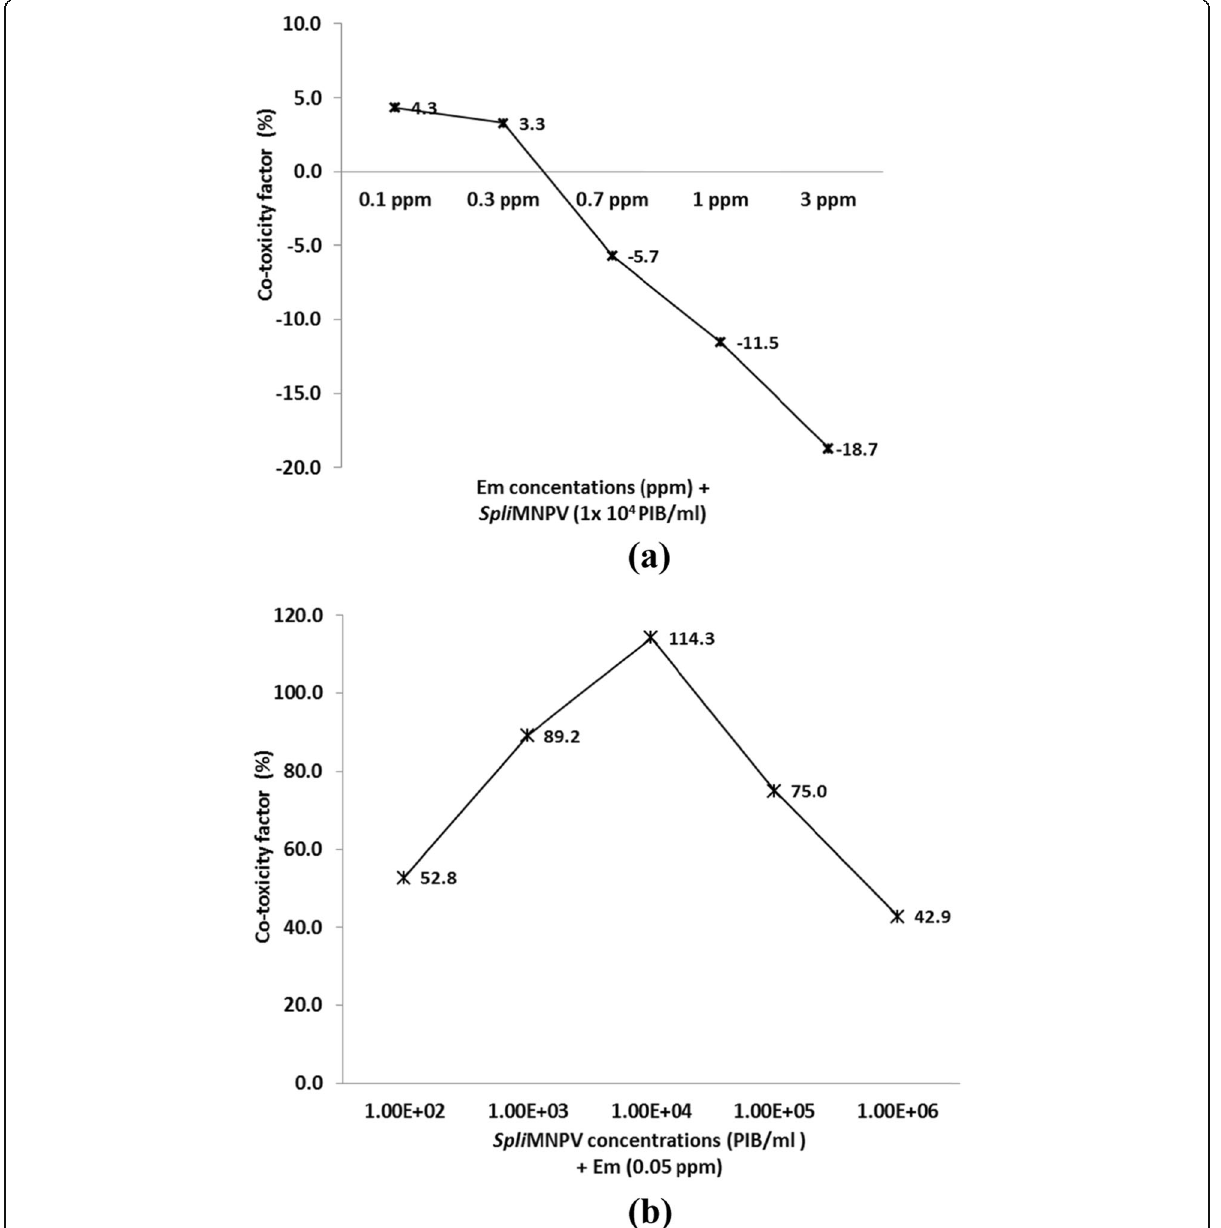
Fig. 3 % Co-toxicity factors of Spodoptera littoralis 2nd instar larvae treated with the two different mixture treatments a Spli MNPV concentrations (PIB/ml) + Em (0.05 ppm) and b Em concentrations (ppm) + spli MNPV (1 × 10 4